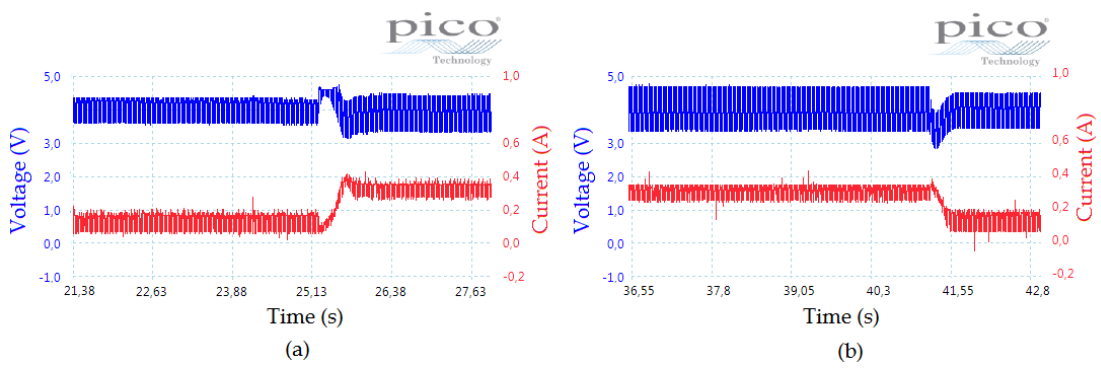
Figure 14. PV voltage and current time evolution by employing the P&O method (a zoomed in